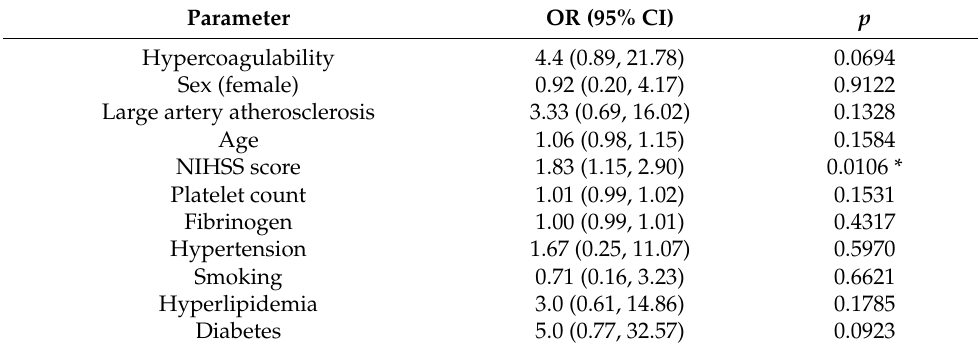
Table 3. Univariate logistic regression analysis of predictors of a large size (>2 cm 3 ) of acute ischemic